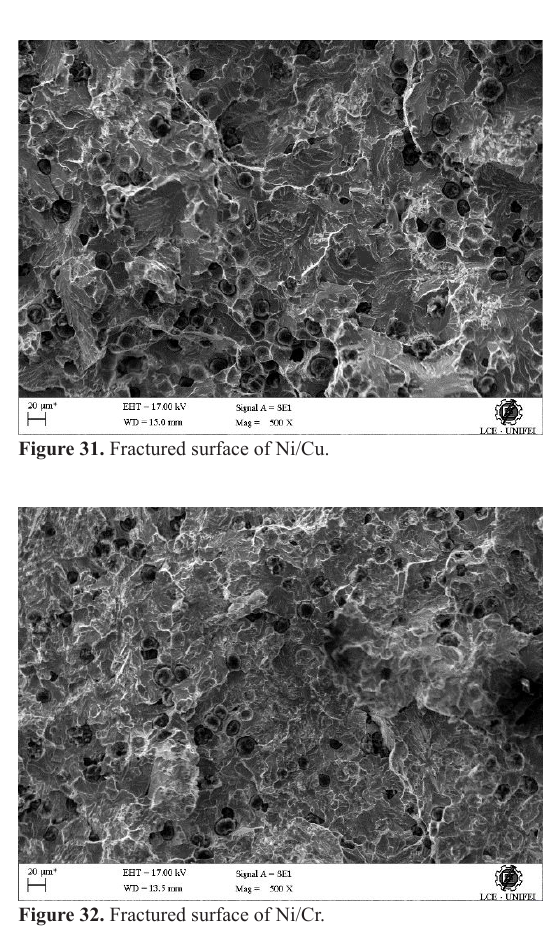
Figure 30. Charpy results for each condition.